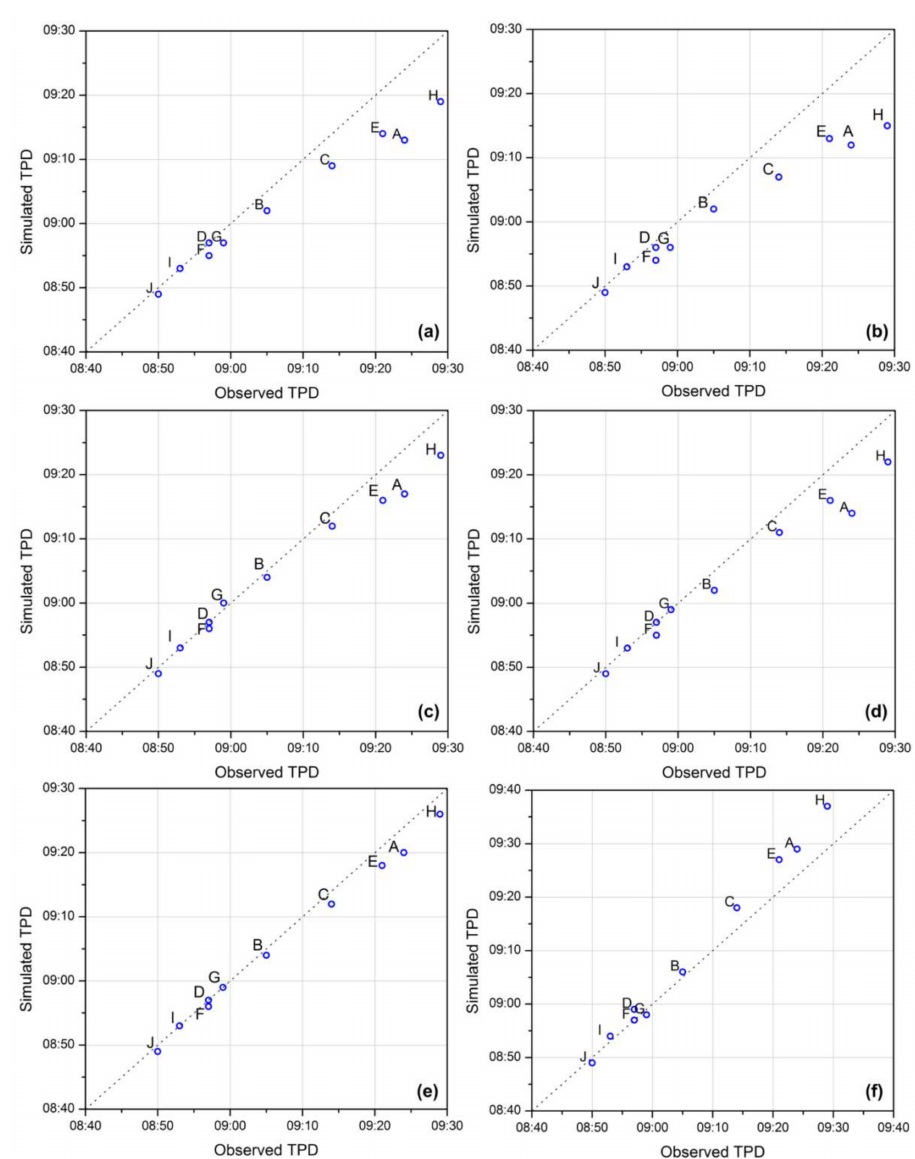
Figure 16. A comparison of observations and simulated timing of peak depth (TPD) at each monitoring point (from points A to J) resulted from varying building treatment methods: ( a ) BB method; ( b ) BH method; ( c ) IBTA0.4 method; ( d ) IBTA0.6 method; ( e ) IBTA0.4R method; and ( f ) BR